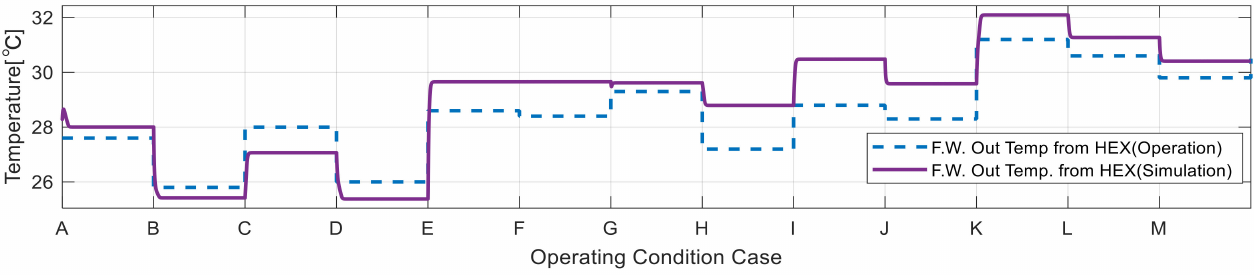
Figure 12. Comparison of simulation and operational data for FW output temp from